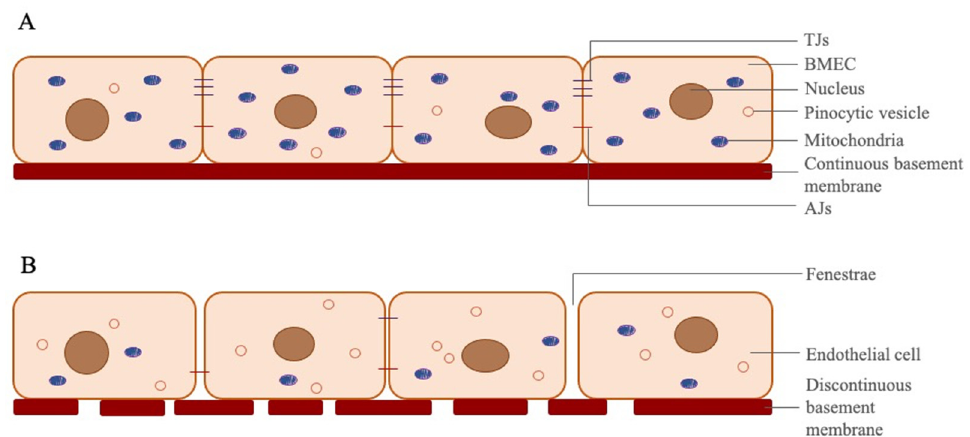
Figure 1. Differences between BMECs and peripheral endothelial cells. ( A ) BMECs line along a continuous basement membrane in cerebral capillaries. These cells have tight and adherens junctions to prevent paracellular transition of the molecules in bloodstream. BMECs have 5–6 times more mitochondria than peripheral endothelial cells, due to which transition of the molecules occurs mostly transcellularly in cerebral microvascular capillaries, and BMECs need more ATP than other endothelial cells. They have less pinocytic vesicles than peripheral endothelial cells to reduce transport of unwanted molecules via pinocytosis. ( B ) Peripheral endothelial cells, which have fenestrae, more pinocytic vesicles and less mitochondria, line along a discontinuous basement membrane in peripheral capillaries. These cells have fewer TJs and AJs, and sometimes have wide intracellular gaps to allow transition of molecules via diffusion.